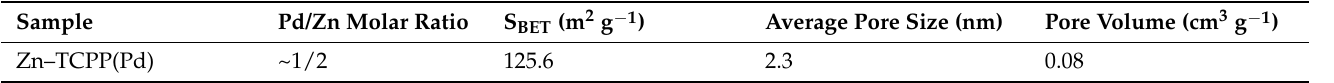
Table 1. Molar ratios of Pd/Zn, and pore structure data of the prepared Zn–TCPP(Pd) MOF nanosheets.